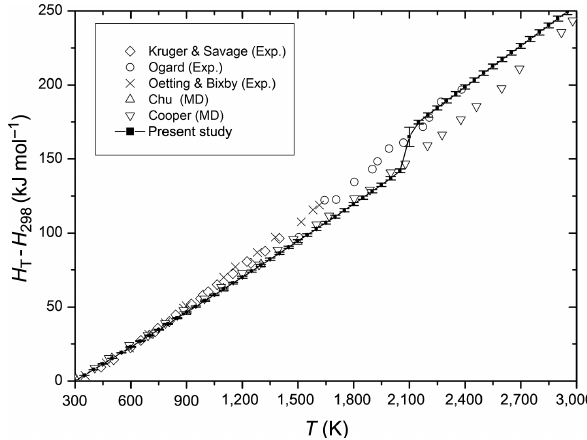
Figure 6: Enthalpy change of PuO 2 with temperature.